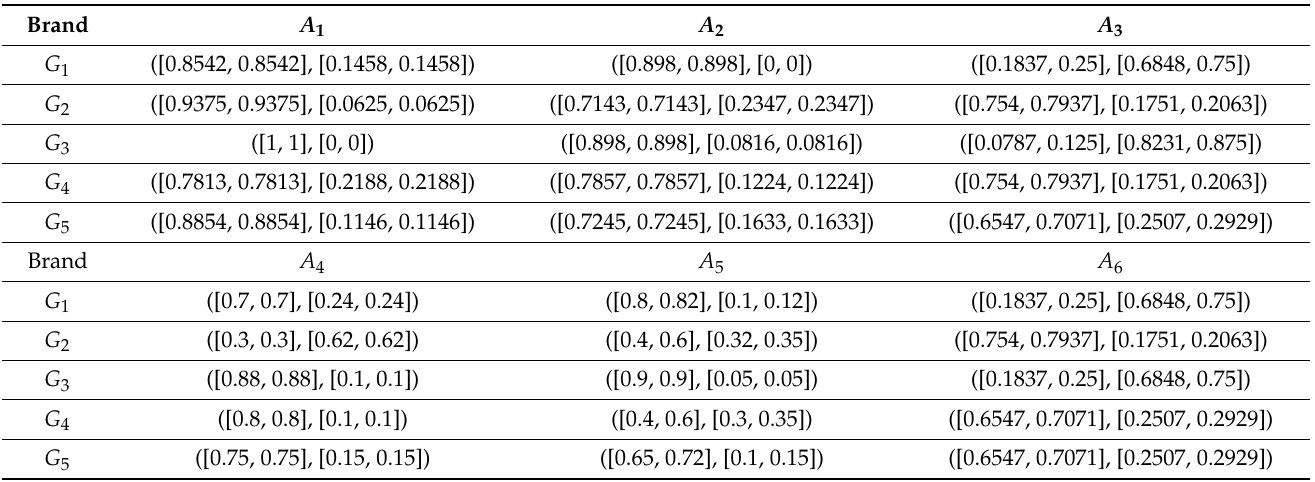
Table 8. The transformed evaluation matrix of expert D 2 .